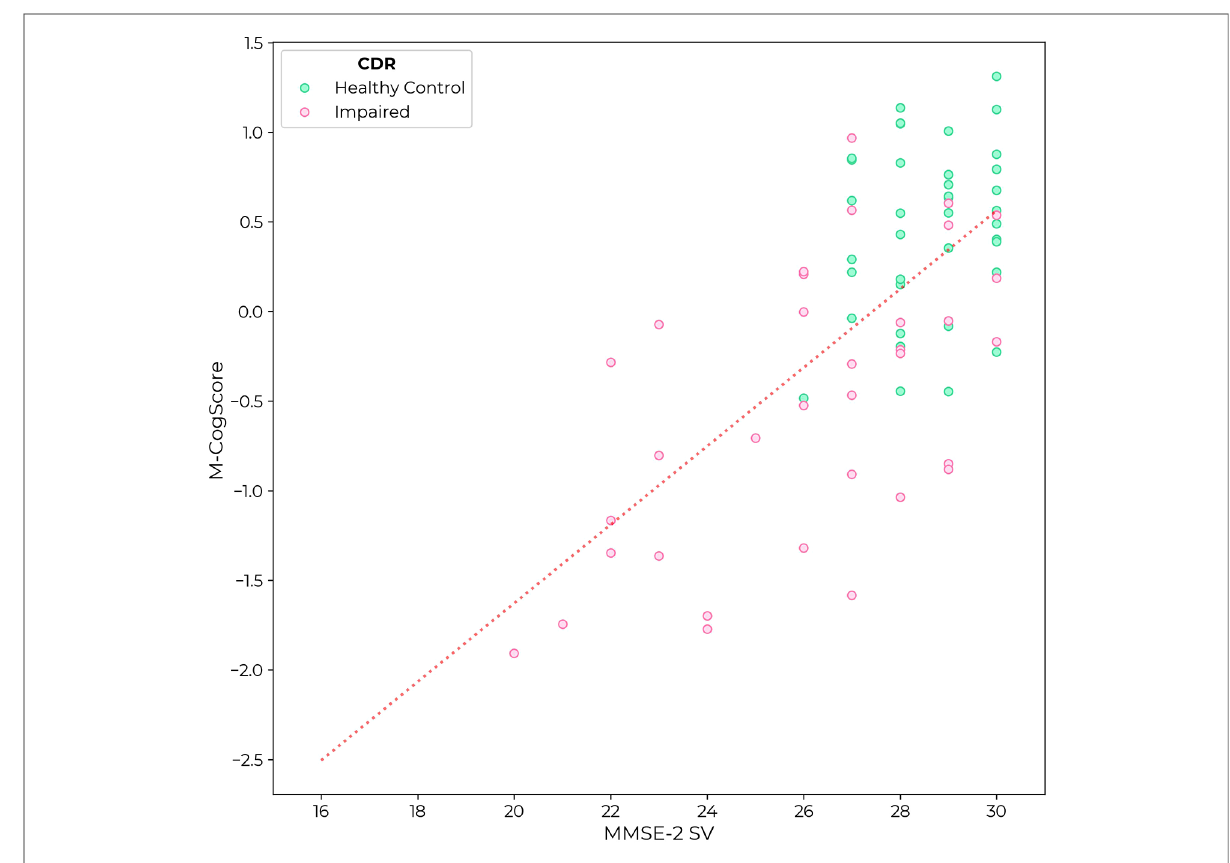
FIGURE 3 M-CogScore vs. MMSE-2 across all participants, labelled by CDR as controls (CDR=0, green) or impaired cognition (CDR 0.5 or 1,